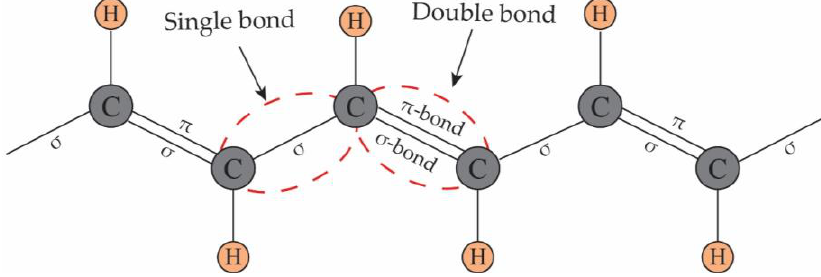
Figure 1. The structure of polyacetylene: The backbone contains conjugated double bonds.